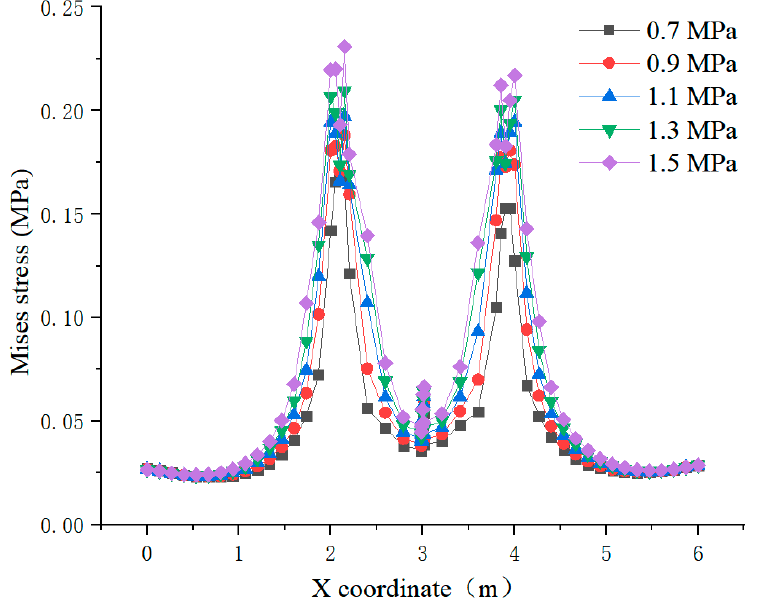
Figure 13. Distribution of dam Mises stress at 14.625 m under different load amplitudes.